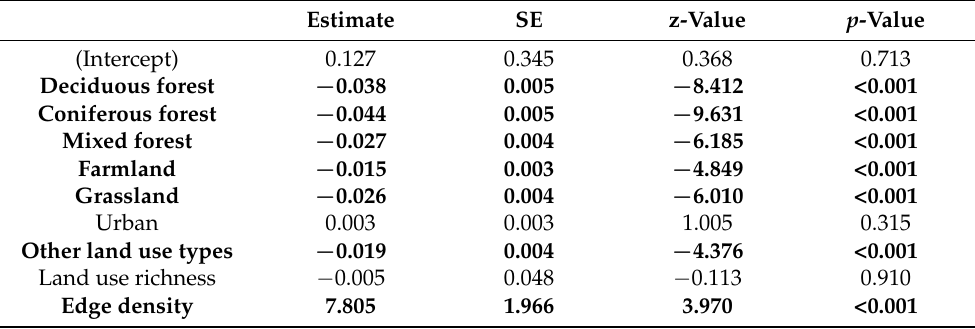
Table 5. GLM model results accounting for the presence and absence of species Eurasian collared dove ( Streptopelia decaocto ) concerning different land use types, land use richness, and edge density in 2016. Abbreviations: SE—standard error. Significant variables are highlighted in